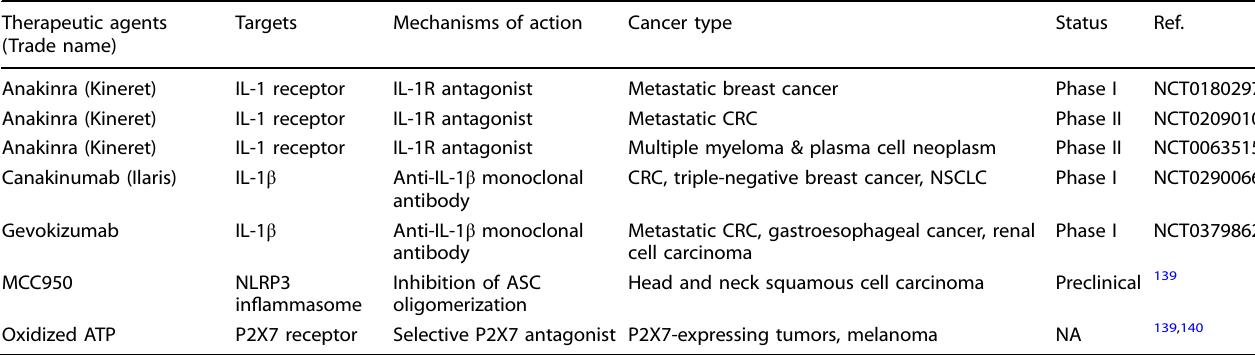
Table 3. Pharmaceutical target of in fl ammasome in